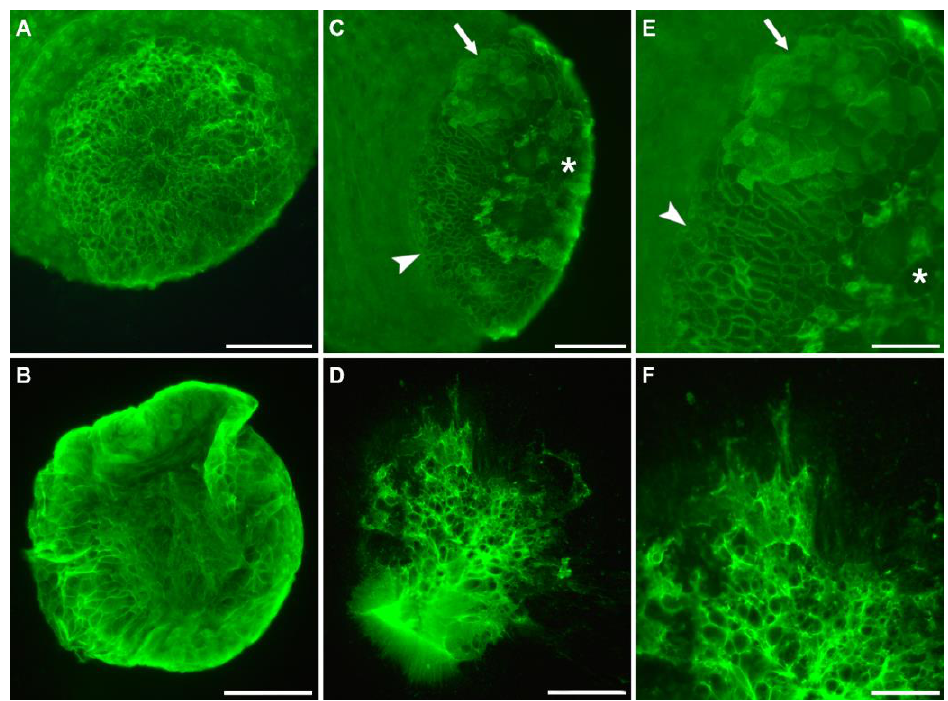
Figure 4. Representative lectin labeling of Hydra basal disc and the corresponding footprint with WGA. ( A ) Basal disc of a voluntarily detached Hydra and ( B ) corresponding footprint after 11 min attachment. ( C , E ) Basal disc of a forcibly detached animal and ( D , F ) corresponding footprint after 78 min attachment. Arrowheads indicate the adhesive material accumulated at the basal disc cell borders and arrows point to the adhesive material on the surface of the cells. Asterisks indicate damaged tissue. Scale bars: ( A – D ) 100 µ m; ( E , F ) 50 µ m. Localization of footprint-specific glycans within the basal disc